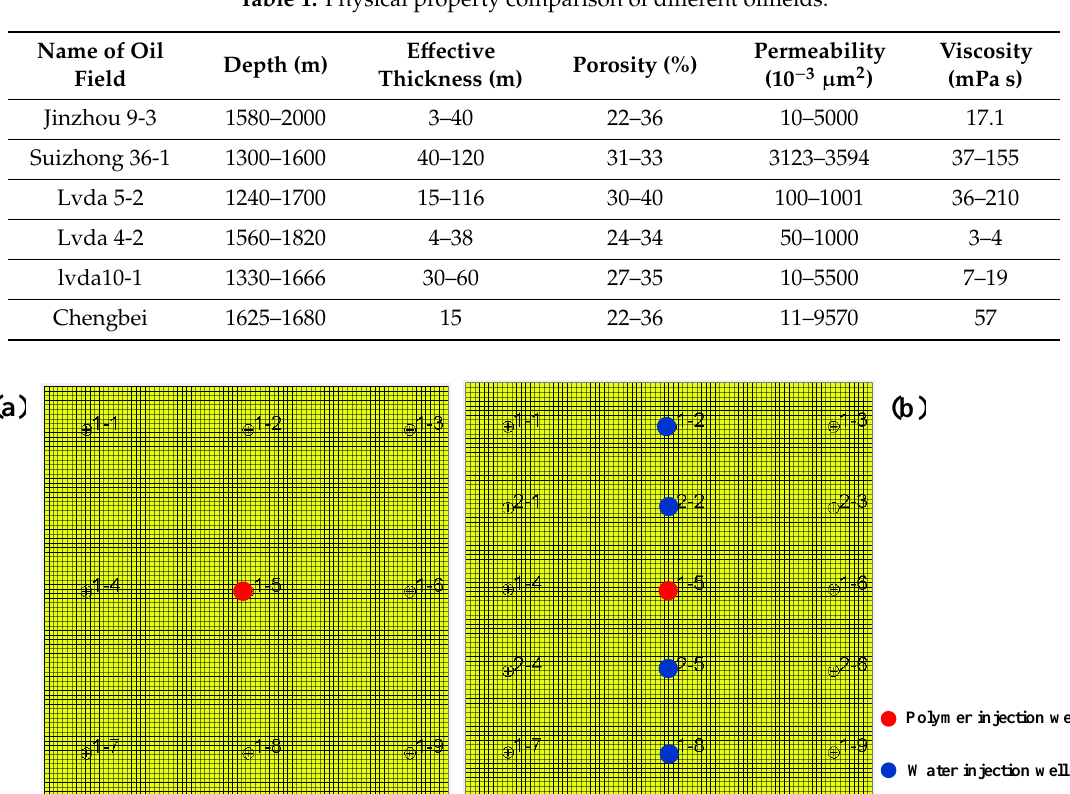
Table 1. Physical property comparison of di ff erent oilfields.